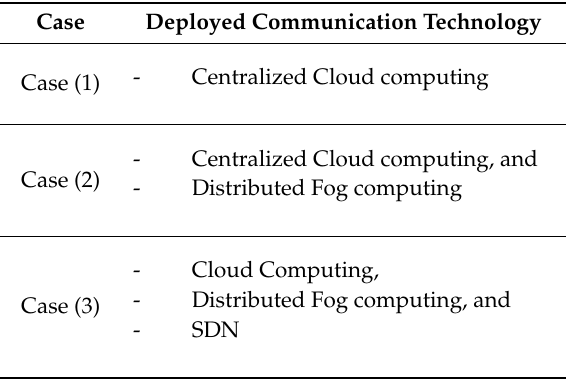
Table 3. The considered simulation